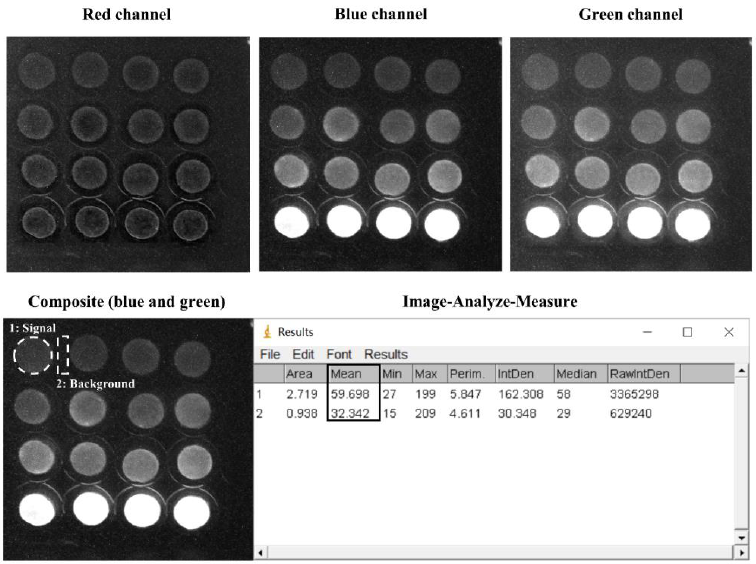
Figure 3. Exemplary data analysis of smartphone-taken images of the immobilized bioreporter bacteria on the filter membrane disks.